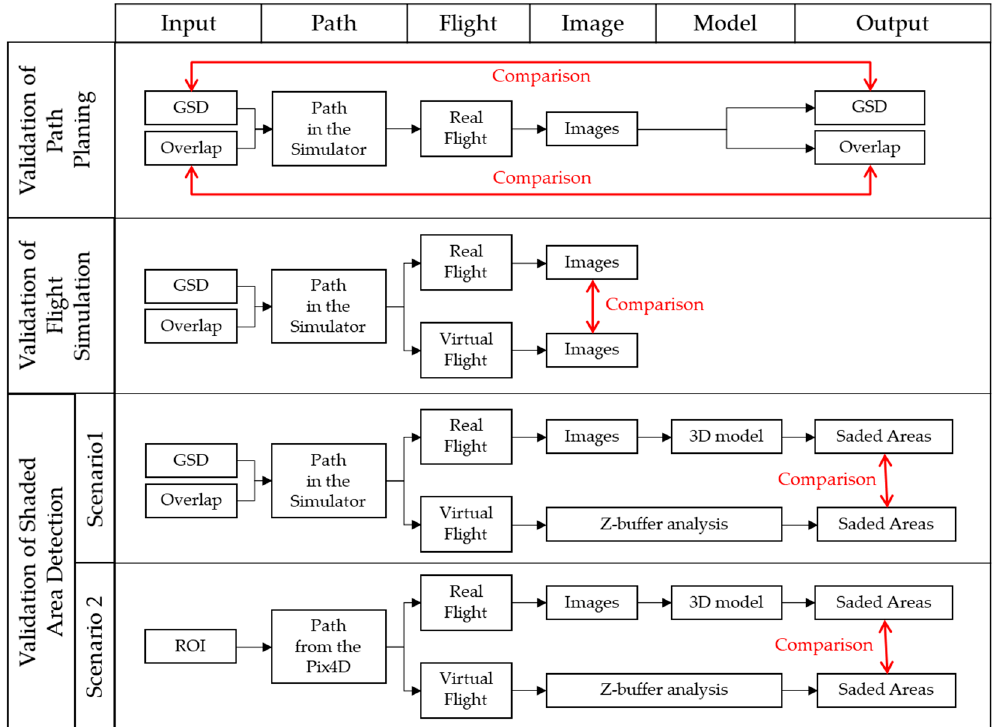
Figure 5. Validation process of three functions and their indicators in the overall simulation process.